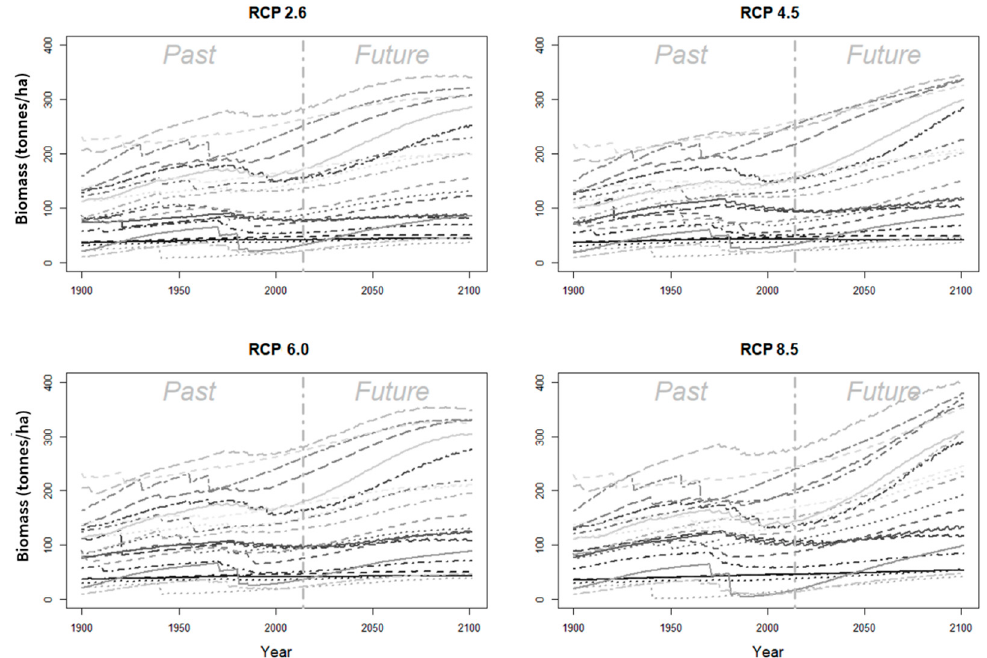
Figure 6. Average quantity of biomass (tonnes/ha) in the 22 ecoregions (different line styles) under the four climate change scenarios: RCP 2.6, RCP 4.5, RCP 6.0 and RCP 8.5.